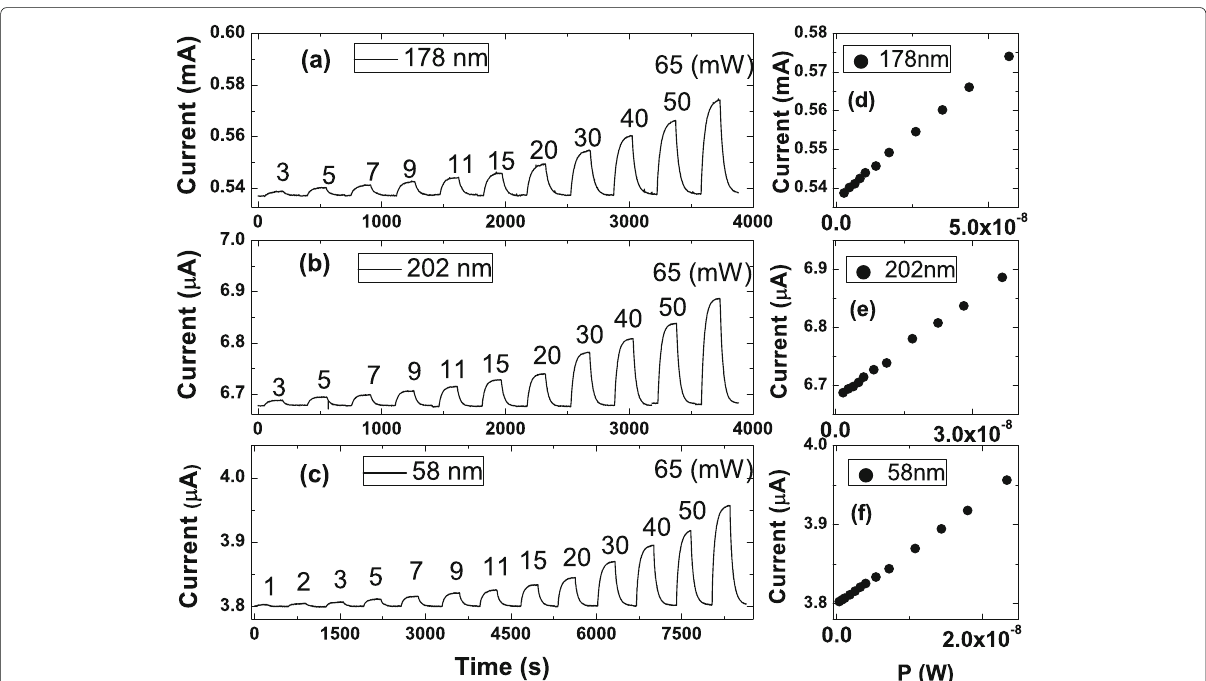
Fig. 2 a , b , and c show the measured currents as a function of light power intensity in three samples with different thicknesses. d , e , and f reveal that the measured currents are proportional to the light power intensity. It comes to our attention that the larger I on is observed in the nanosheet with larger I off